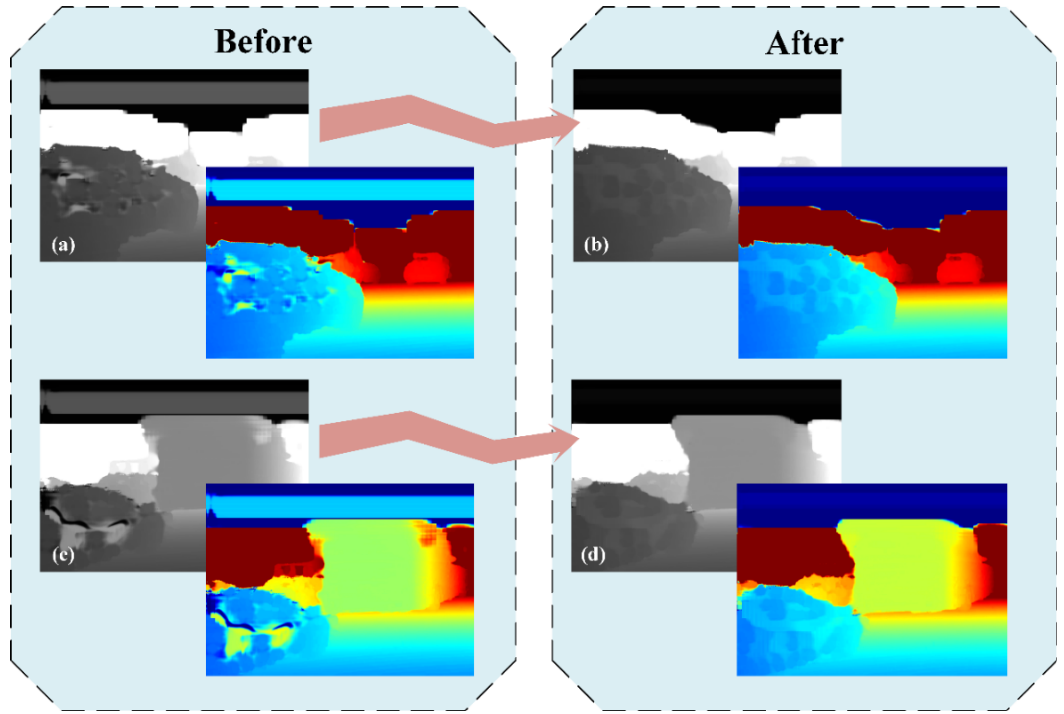
Figure 9. The effects of the point folding module. ( a , c ) are the results without point folding modules. ( b , d ) are the results of somewhat folded modules.